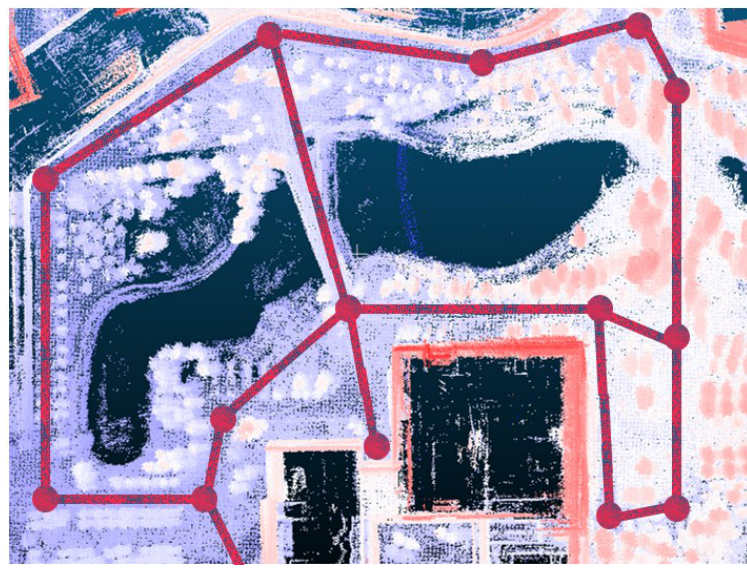
Figure 17. Global topology map in the park